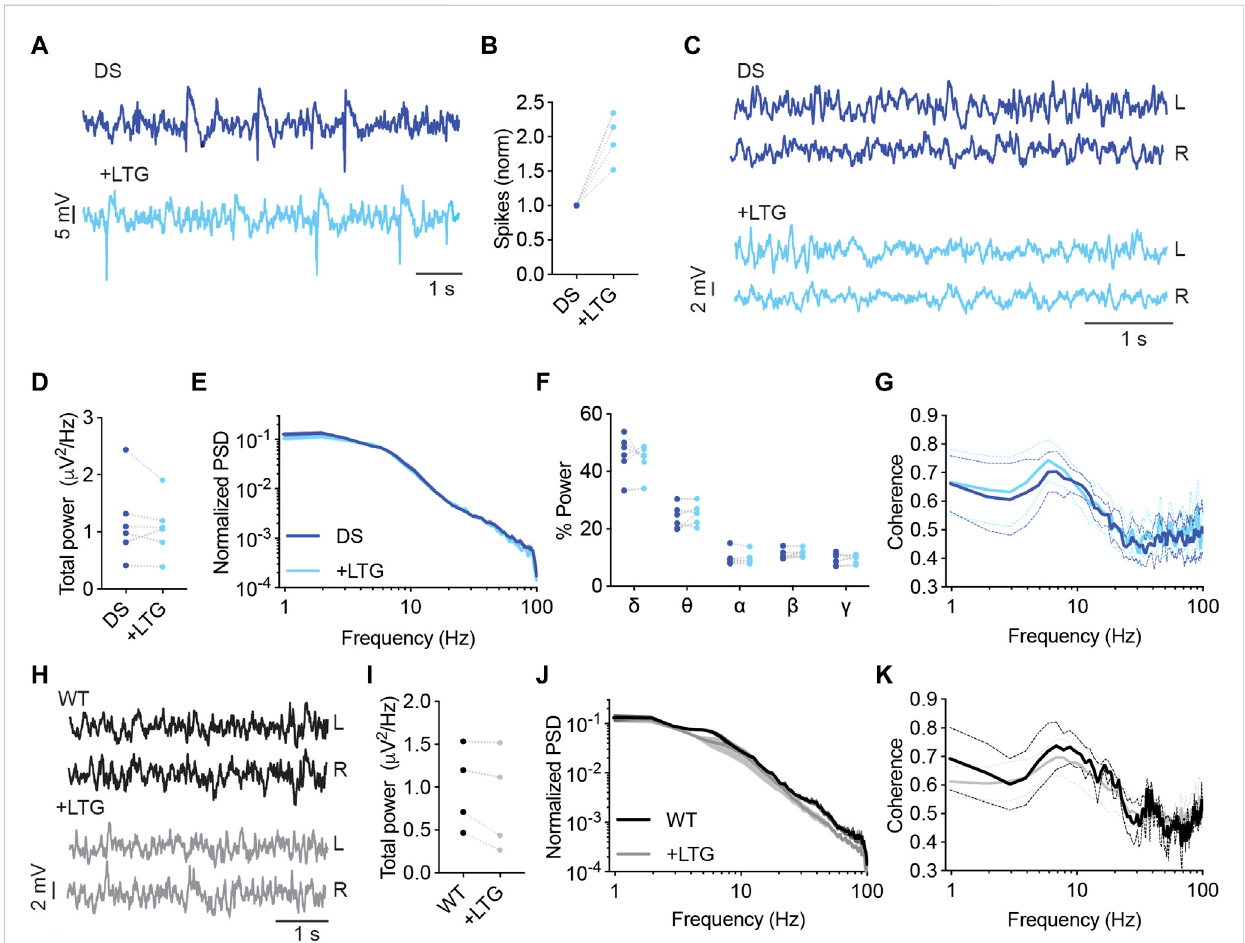
FIGURE 7 LTG increased the frequency of interictal spikes in DS mice. (A) Representative traces of epileptic activity in DS mice before and after acute administration of LTG (10 mg/kg). (B) The effect of LTG on interictal spike frequency. (C) Representative traces of background ECoG in DS mice before and after treatment with LTG. (D) The effect on total power. (E) ECoG power density pro fi les normalized to the absolute total power prior to drug administration. (F) The relative power in each frequency band. (G) Interhemispheric coherence plotted over the 1 – 100 Hz spectrum. DS, n =6. (H) Representative traces of background ECoG from WT mice, before and after administration of LTG. (I) The effect of LTG on total power. (J) ECoG power density pro fi les normalized to the absolute power prior to drug administration. (K) Interhemispheric coherence plotted over the 1 – 100 Hz spectrum. WT, n =